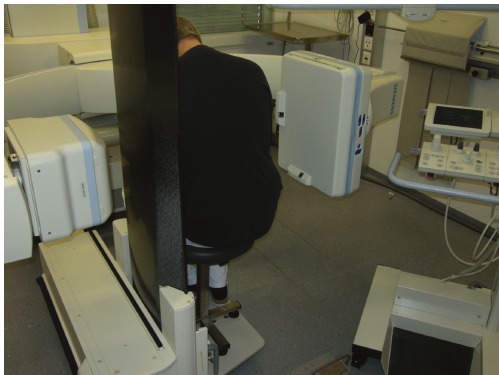
Figure 2: Volunteer demonstrating the patient position for the lumbar